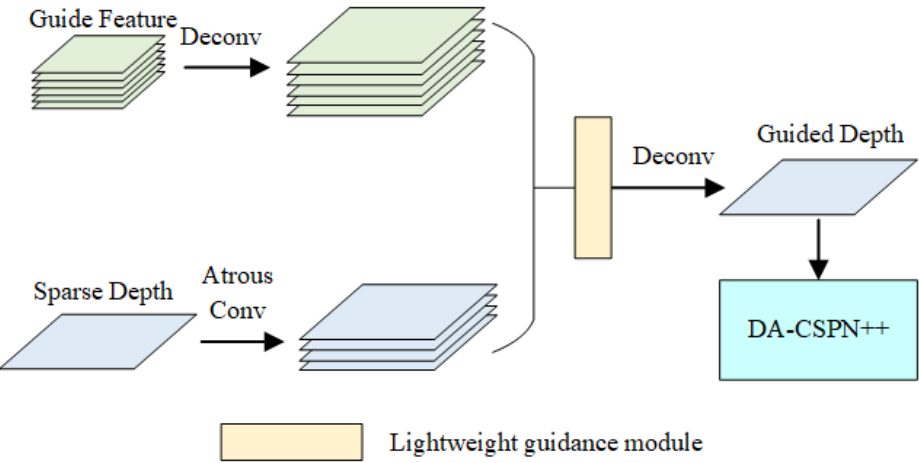
Figure 5. Schematic diagram of the structure of the depth information completion module. The high- dimensional depth map information input to DA-CSPN++ is complemented by the null convolution as well as the same dimensional guidance features to make the high-latitude features have a better positive effect on the redirection of the dense depth